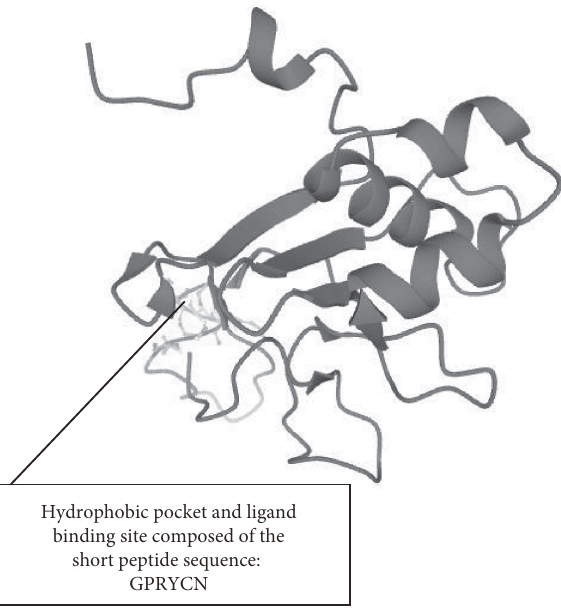
Figure 3: Predicted ligand binding sites